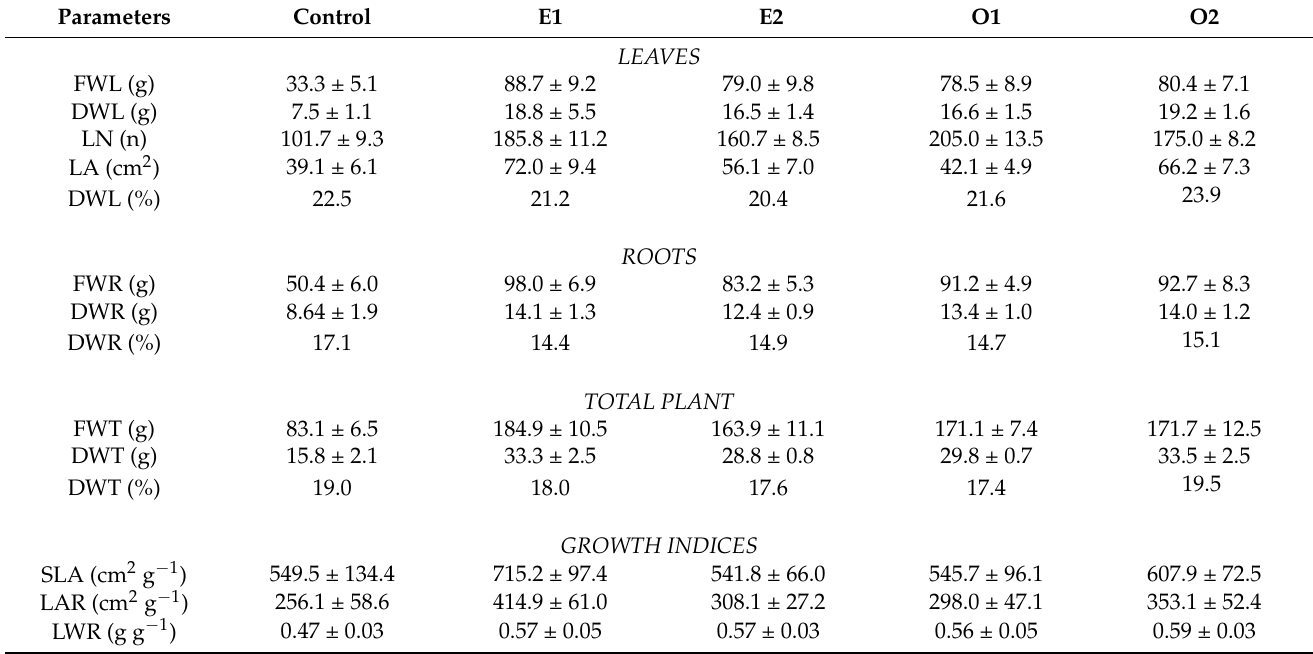
Table A4. Effect of different applications of biostimulants on the growth parameters of Tanacetum balsamita L. (Means and